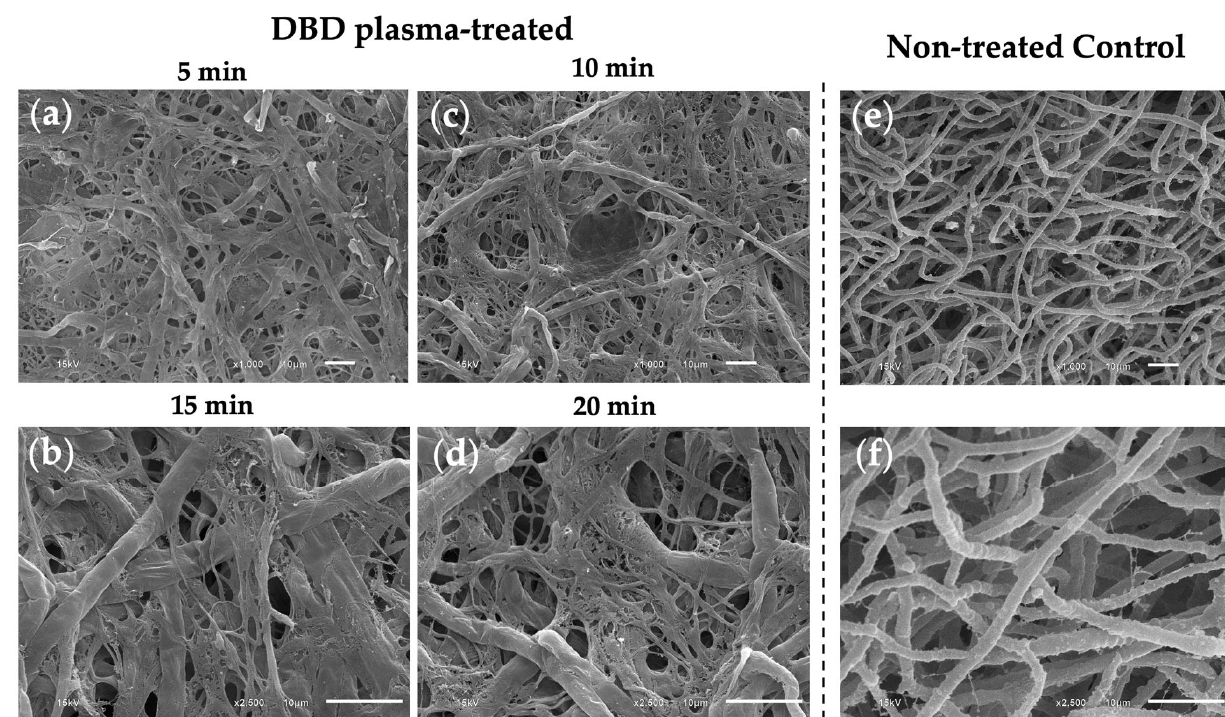
Figure 3. Scanning electron micrographs of Athelia rolfsii mycelia ( a – d ) after exposure to DBD plasma for 5, 10, 15, and 20 min compared with the non ‐ treated control ( e , f ). Mycelia treated with the DBD plasma showed characteristics of laceration, whereas mycelia from a non ‐ treated control showed normal characteristics.